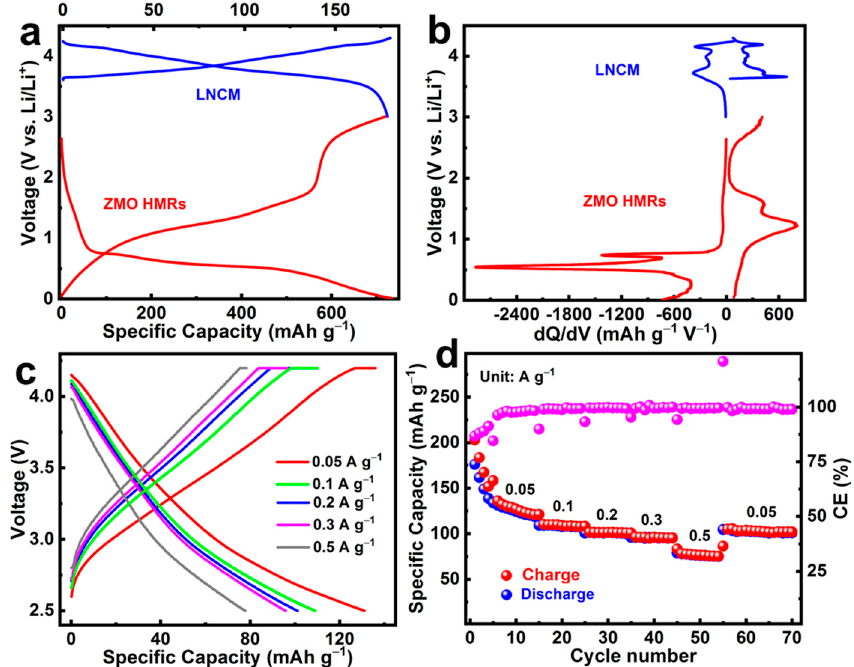
Figure 7. ( a ) The charge–discharge plots of LNCM and ZMO HMRs at 0.1 A g − 1 . ( b ) Corresponding d Q/ d V curves of the LNCM and ZMO HMRs. ( c ) Charge and discharge profiles, and ( d ) rate capability of LNCM/ZMO HMRs full battery.